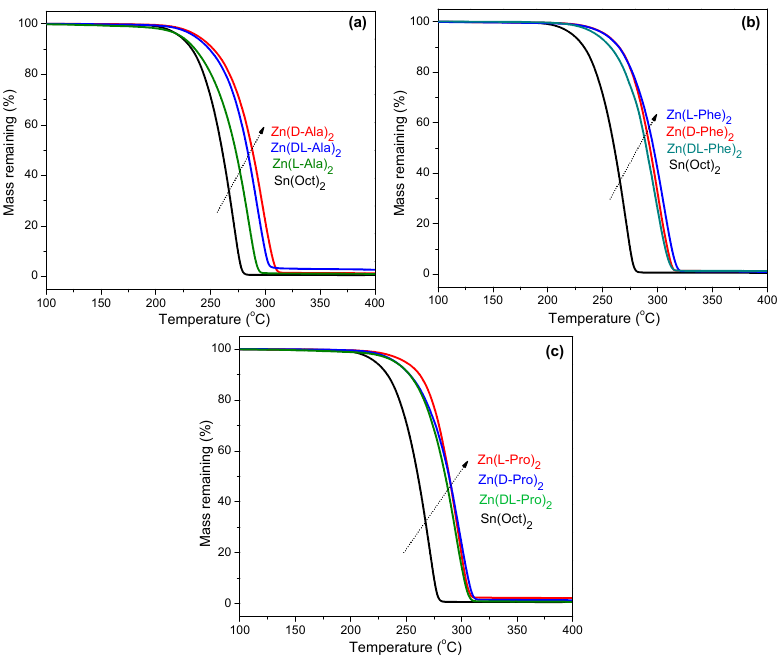
Figure 6. TGA curves of PLLA obtained by ( a ) Zn(Ala) 2 , ( b ) Zn(Phe) 2 , ( c ) Zn(Pro) 2 (Sn(Oct) 2 as reference).